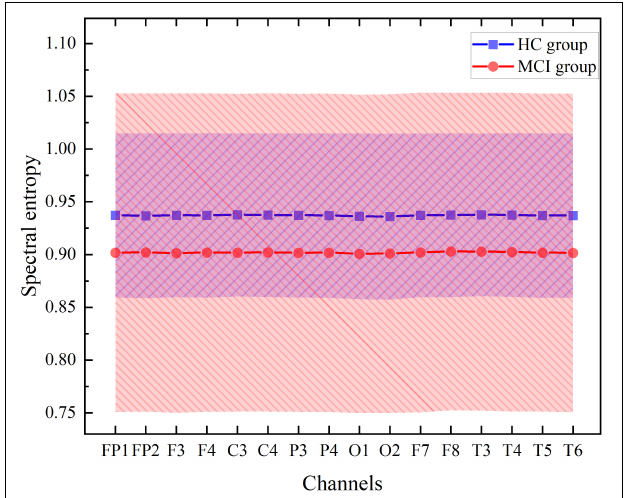
FIGURE 12 | Topographic map of the average value of 8 convolution kernel (kernel-size = 1 × 1) weights corresponding to EEG signal